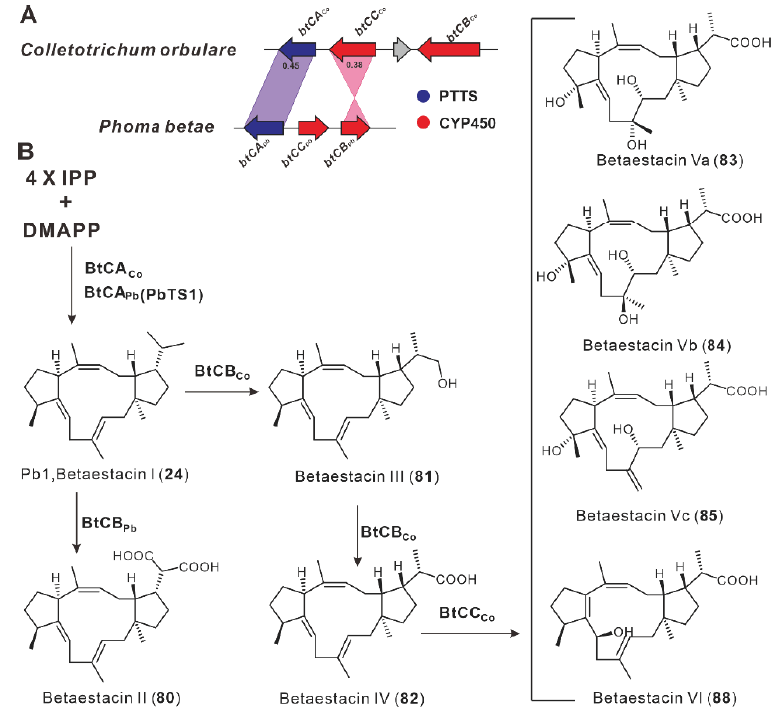
Figure 9. The BGC for betaestacins ( A ) and their biosynthetic pathway ( B ). During genome mining of B. maydis in 2018, Narita et al. discovered a BGC consisting of four genes (Figure 10A). The heterologous expression of the bifunctional terpene syn- thase (TpCA) in A. oryzae produces preterpestacin I ( 23 ). The compound 23 is hydrox- ylated regioselectively by CYP450 (TpCB) to produce preterpestacin II ( 87 ), which is then further oxidized to the carboxyl group to form 88 . The two-step oxidation of 87 catalyzed by a second cytochrome P450 (TpCC) yields vicinal diol moiety on the α -ring to form pre- terpinomycin III ( 89 ). The oxidation of the two hydroxyl groups on the A-ring of 89 is catalyzed by flavin-dependent oxidase (TpCD) to form a diketone, which forms 90 via a keto-enol interchange [49]. Figure 10. The tpc BGC ( A ) and their biosynthetic pathway ( B ). FgMS is a PTTS from F. graminearum responsible for the production of 25 and was identified by Bian et al. in 2017 [32]. Yuan et al. conducted a deeper excavation of the genome to reveal a BGC (Figure 11A) containing FgMS and characterized the BGC with the help of the efficient A. oryzae chassis, showing that this BGC is responsible for the